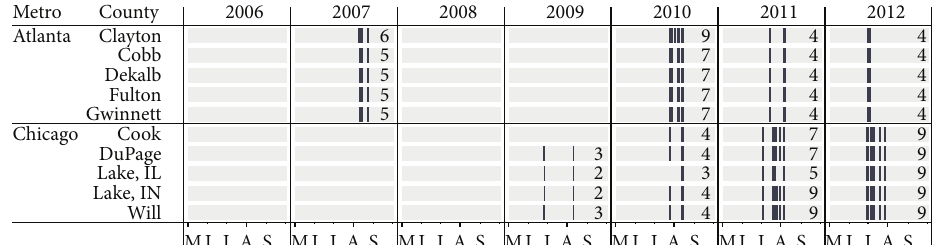
Figure 2: Recorded National Weather Service Heat Advisories are shown (black) for May–September 2006–2012 by county. Annual county totals are also